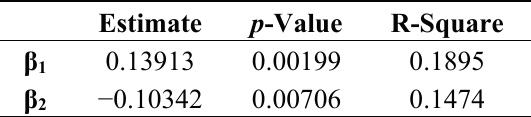
Table 2. Linear regression estimation